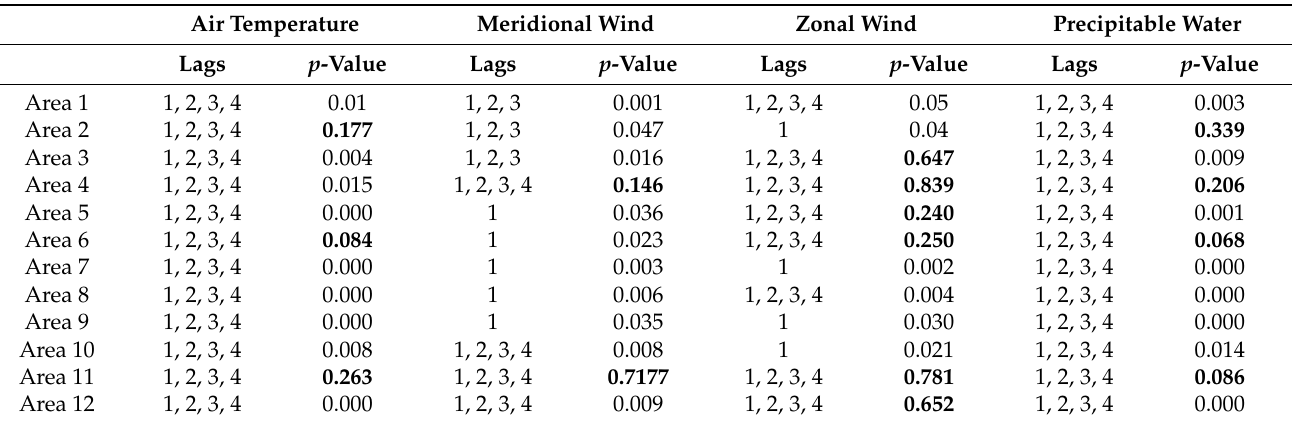
Table 5. Granger causality p -values and number of lags used for the models relating climatic variables and NDVI time series of each segmented area of the